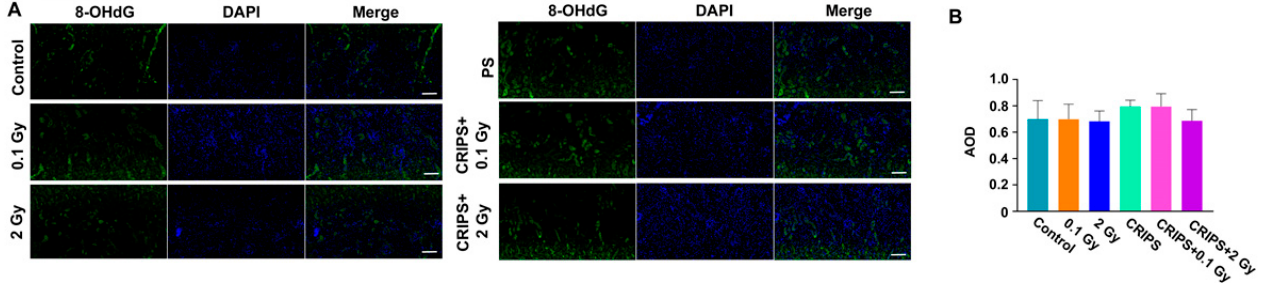
Figure 2. Expression of 8-OHdG, detected in renal sections in Trp53 +/ − mice. A , the expression of 8-OHdG was analyzed by immunofluorescence (magnification, 200×; scale bar = 100 µM); B , the average AOD of 8-OHdG in each group. CRIPS, chronic restraint-induced stress; AOD, the average optical density (Integrated optical density/area).